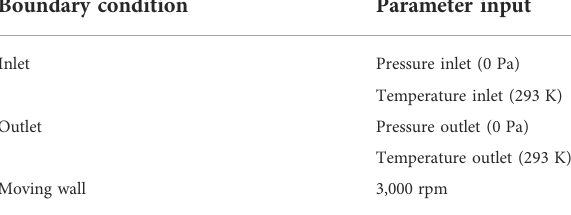
TABLE 2 Boundary conditions in simulation ANSYS.